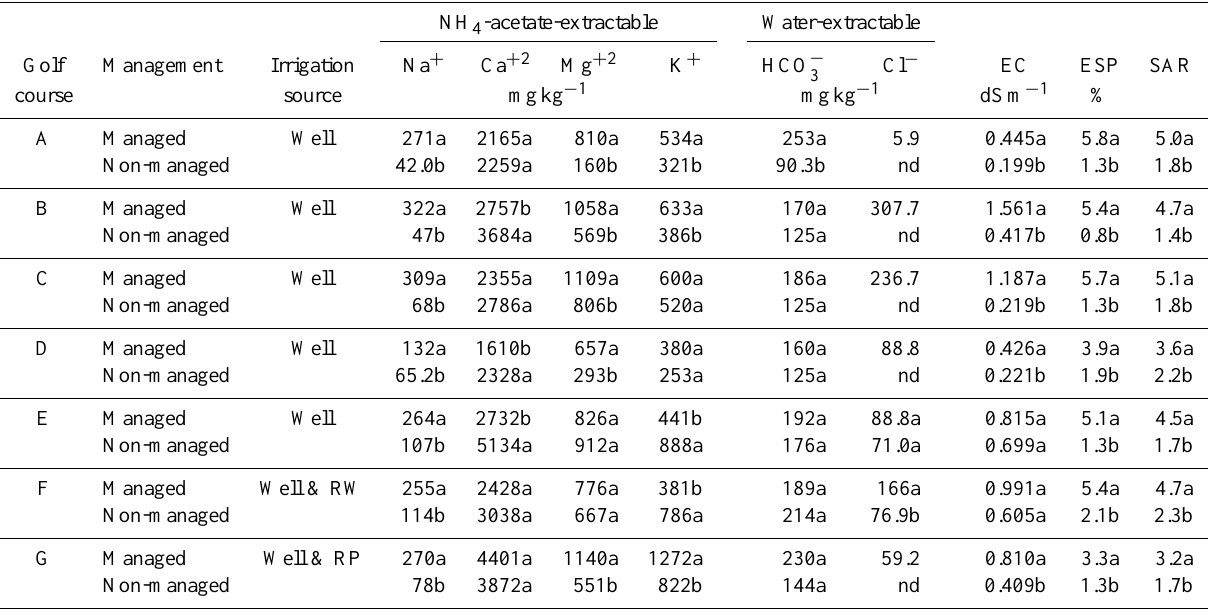
Table 2. A summary of extractable ions and soil salinity parameters for the managed and non-managed areas of the seven golf facilities studied in Lubbock, Texas, USA ( n =